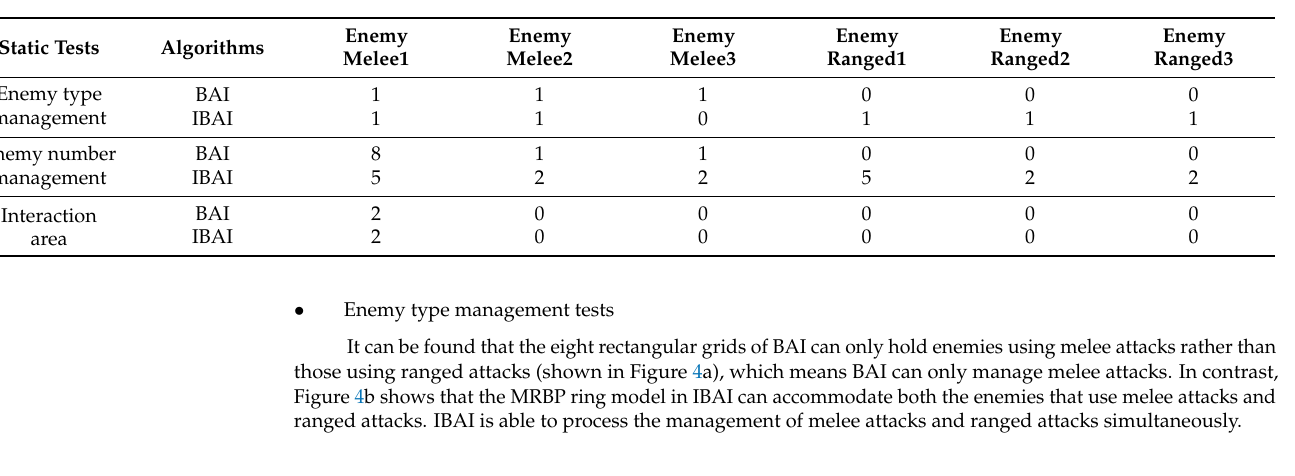
Table 4. Table 4. Type and number of enemies used in each static test.